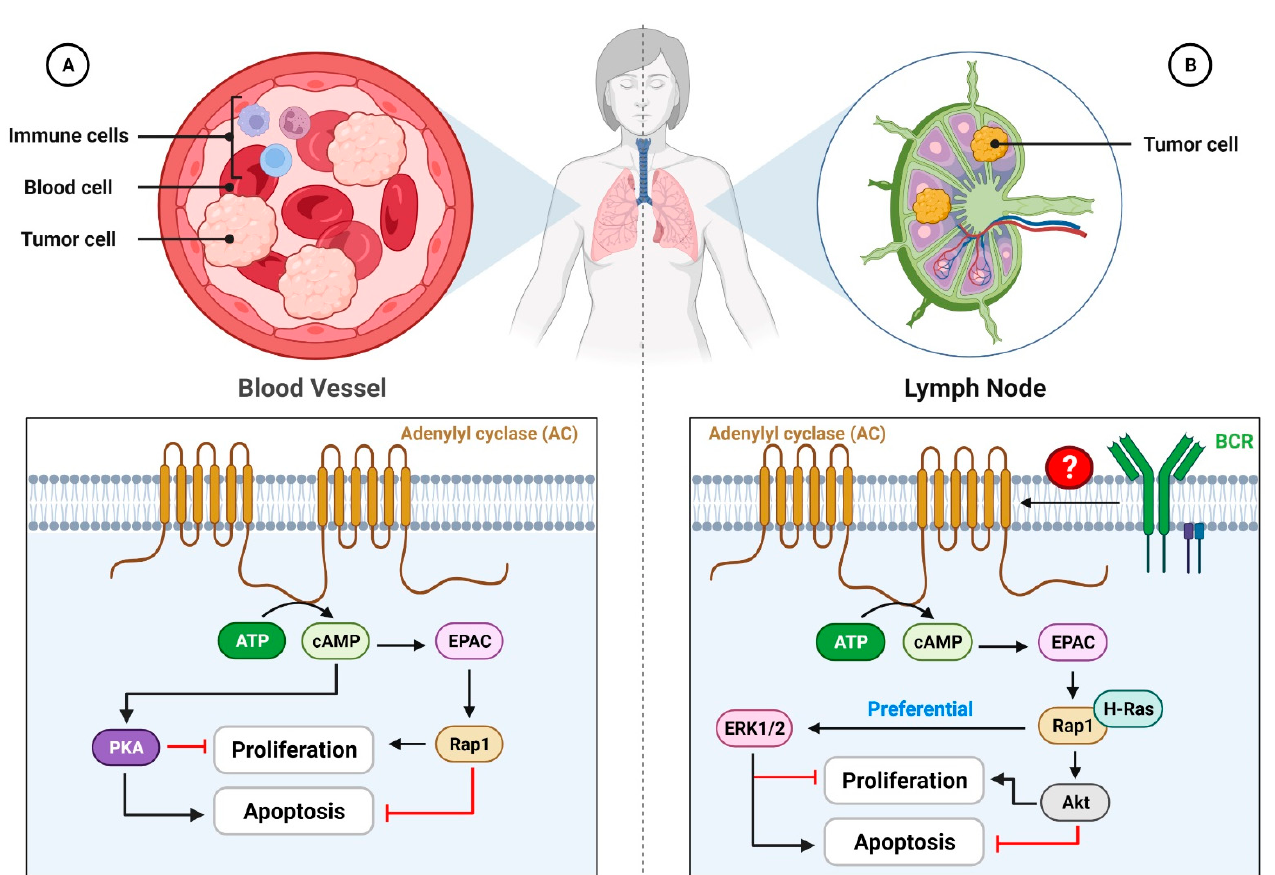
Figure 5. Diverse blood cancers respond differently to EPAC. ( A ) EPAC increases cell proliferation and survival while decreasing apoptosis in both B-cell chronic lymphocytic leukemia and acute lymphoblastic leukemia. Although both EPAC and PKA are downstream consequences of cAMP, their functions are diametrically opposed. EPAC, as opposed to PKA, inhibits apoptosis through Rap1 and promotes cell survival in the body. ( B ) EPAC induces cell growth arrest and death in immature B-cell lymphoma. To put it another way, cAMP levels rise when the BCR is activated. Accumulated cAMP then increases EPAC, which in turn, activates ERK1/2, which promotes apoptosis and Akt, which inhibits it, through Rap1 and H-Ras. Inhibition of cell growth and an increase in apoptosis are the likely outcomes of this activation, which seems to favor ERK. PKA, protein kinase A; EPAC, exchange protein directly activated by cAMP; BCR, B-cell antigen receptor; RAP1, Ras-related protein 1; ERK, extracellular-signal-related kinase.